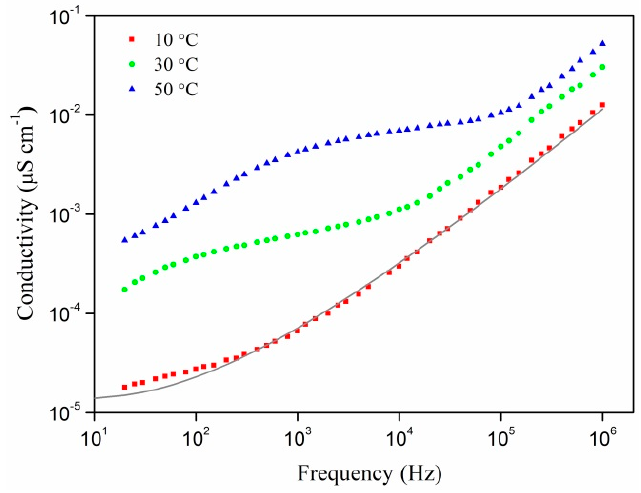
Figure 7. Conductivity vs. AC frequency plot for Ag/PAN nanocomposites prepared at 10 wt.% of AgNO 3 and 15 wt.% of PI without an account of the polymer conductivity at different temperatures of measurements. The solid line shows the theoretical curve according to the Dyre model.